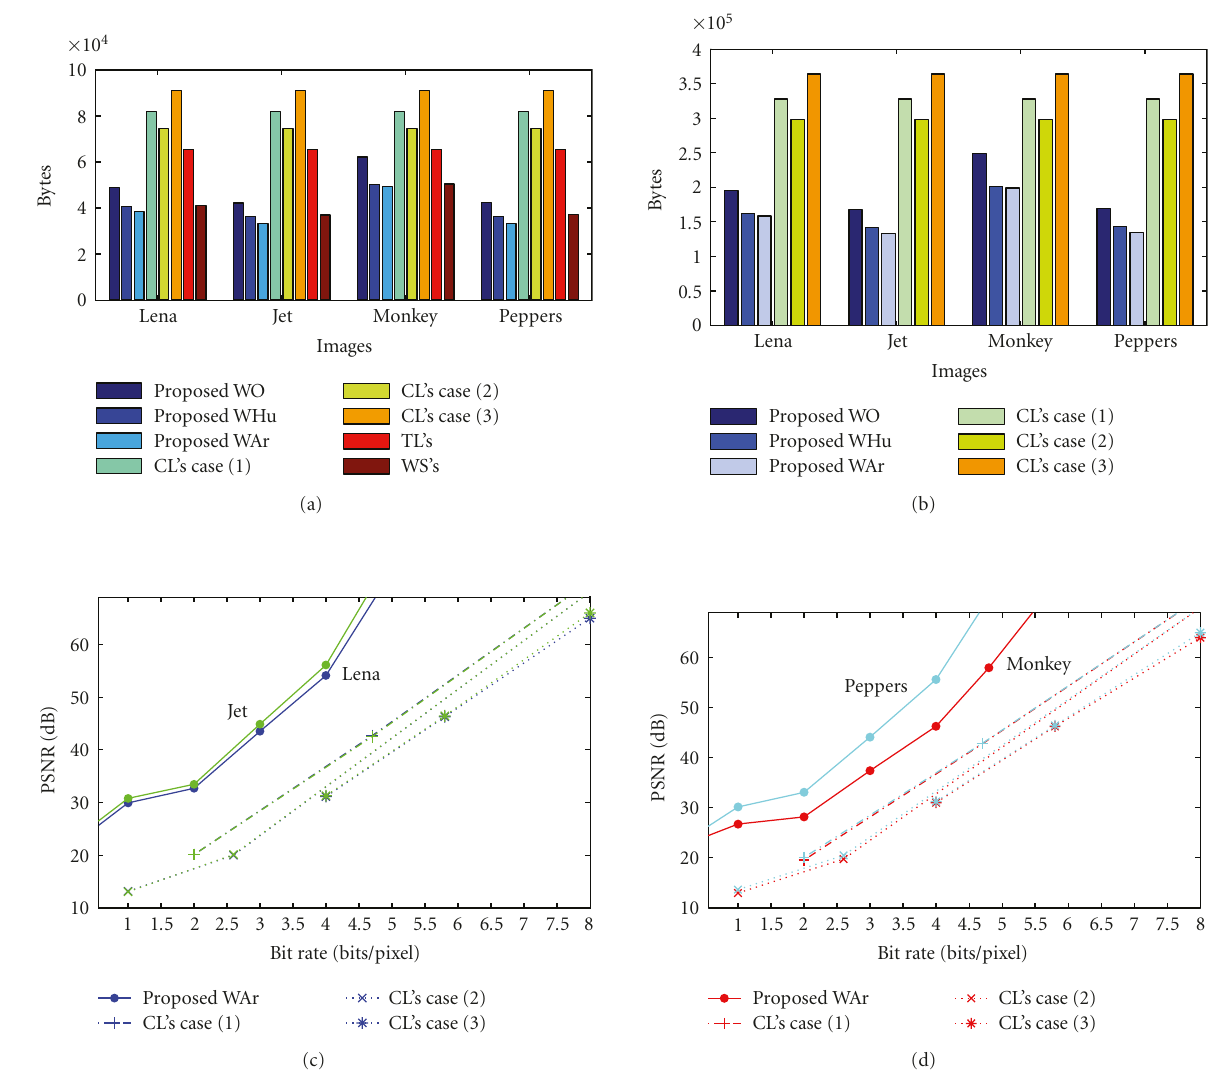
Figure 5: Performance of shadow size and reconstruction quality of the proposed method on four test images (Lena, Jet, Monkey, and Peppers): (a) shadow size comparison (Bytes), (b) number of bytes used for lossless reconstruction, (c) quality (PSNR, dB) of reconstructed images (Lena, Jet) at di ff erent bit rate, and (d) quality (PSNR, dB) of reconstructed images (Monkey, Peppers) at di ff erent bit rate.